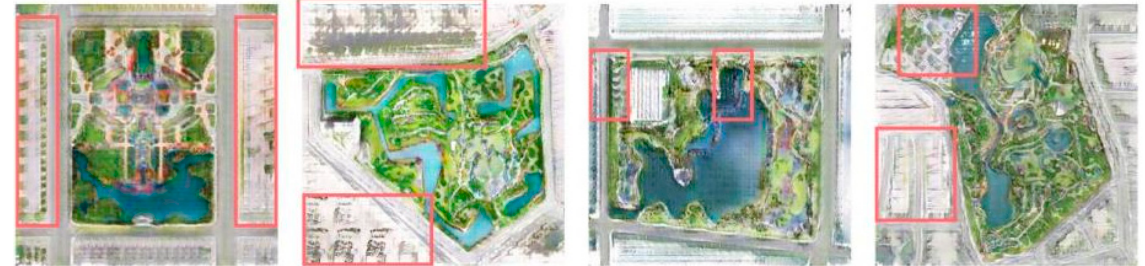
Figure 17. pix2pix model collapse phenomenon.